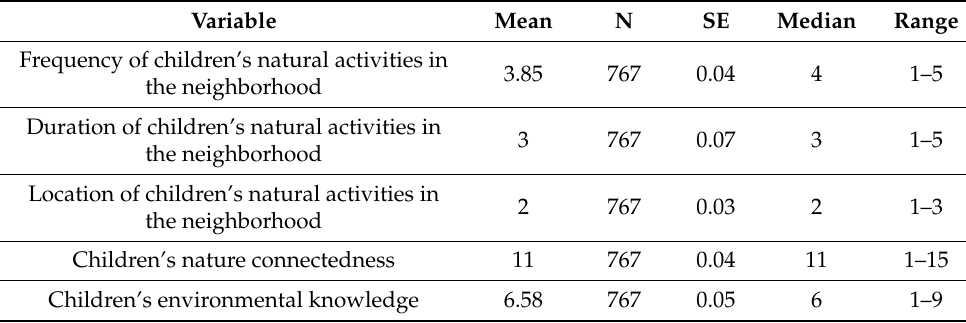
Table 1. Descriptive statistics for relevant variables.